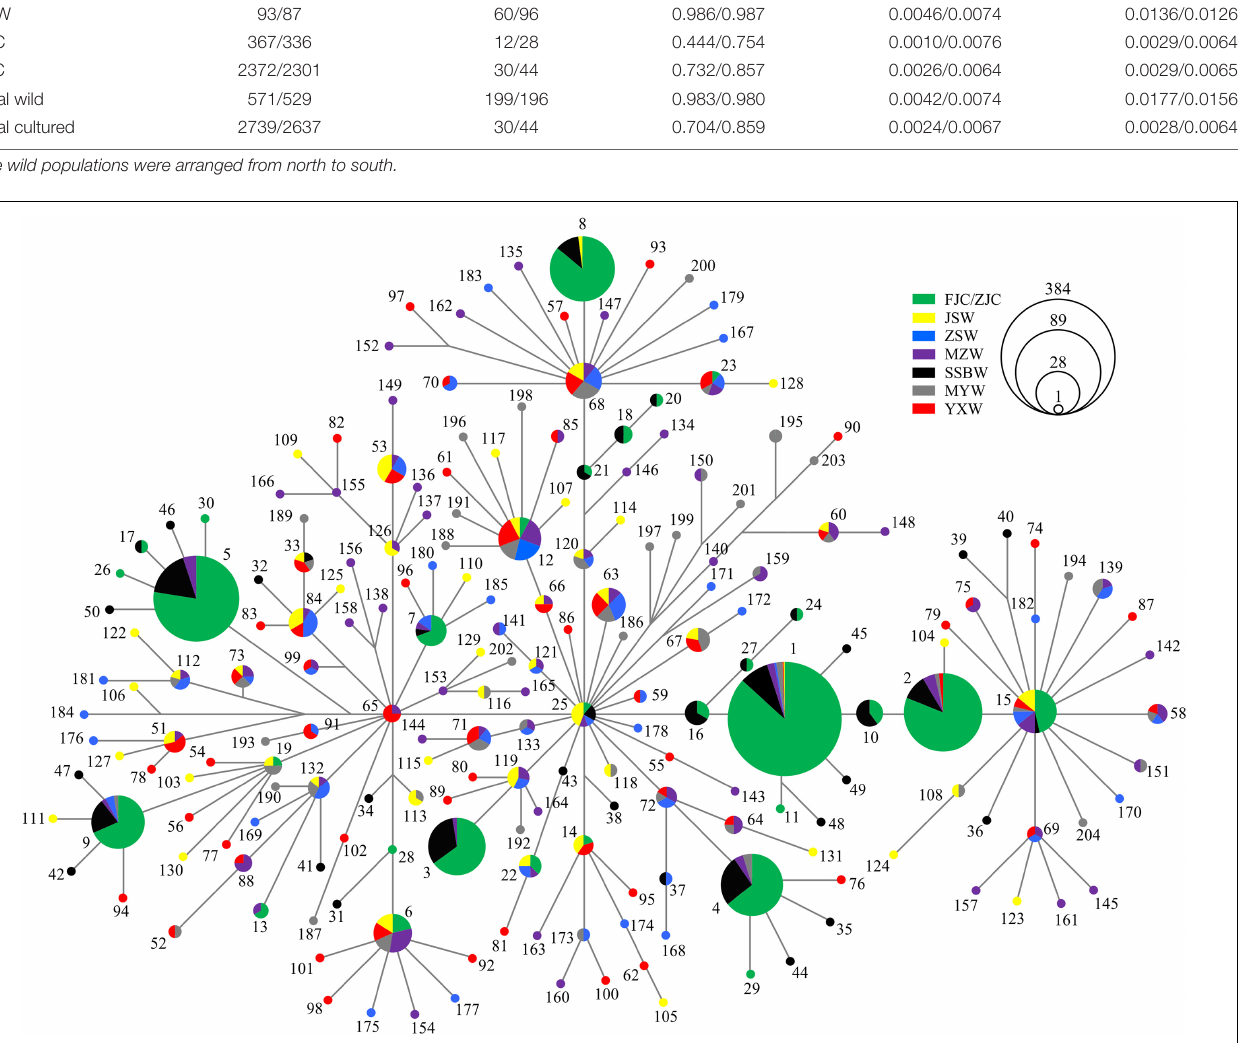
FIGURE 2 | The haplotype network based on mtDNA